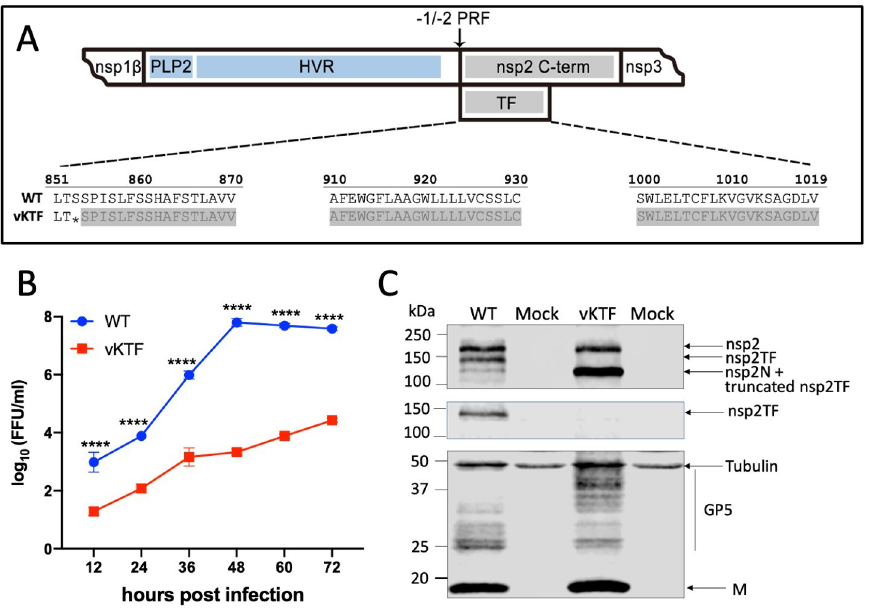
Fig 6. Construction and characterization of PRRSV mutant vKTF. ( A ) Schematic diagram of the engineered nsp2TF truncation. The stop codon introduced in the construct is labeled with an asterisk. The truncated region is shaded with gray. HVR, hypervariable region; nsp2 C-term: nsp2 C-terminal domain that is distinct from that of nsp2TF. ( B-C ) MARC-145 cells were infected with WT virus or its mutant vKTF. Cell lysates were harvested every 12 hpi. ( B ) Growth kinetics comparison of WT virus and vKTF mutant. Each data point represents the mean of three replicates. Virus titers are presented as numbers of fluorescent-focus units (FFU) per milliliter (ml). ���� p < 0.0001. ( C ) Cell lysate harvested at 36 hpi was subjected to Western blot analysis using anti-PLP2 mAb that recognizes the common N-terminal PLP2 domain present in all three nsp2 variants (top panel), the TF-specific pAb (middle panel), or mAbs specific for M and GP5 proteins (bottom panel). Anti-tubulin mAb was used as a